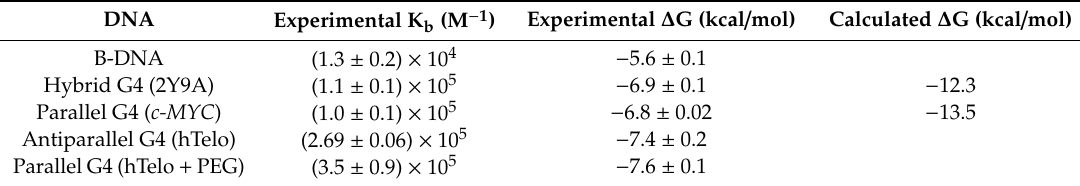
Table 1. Experimental binding constants (K b ) and binding free energies ( ∆ G) for the CHE–DNA complexes. The calculated ∆ G values are also shown for